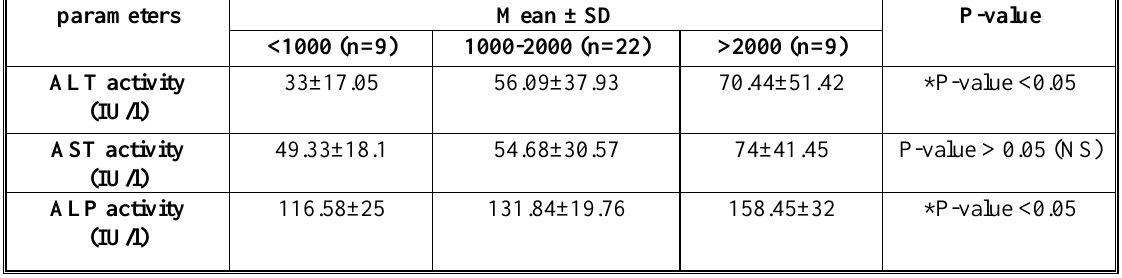
Table5. Effect of Ferritin levels on Serum ALT, AST and ALP in Group A. parameters